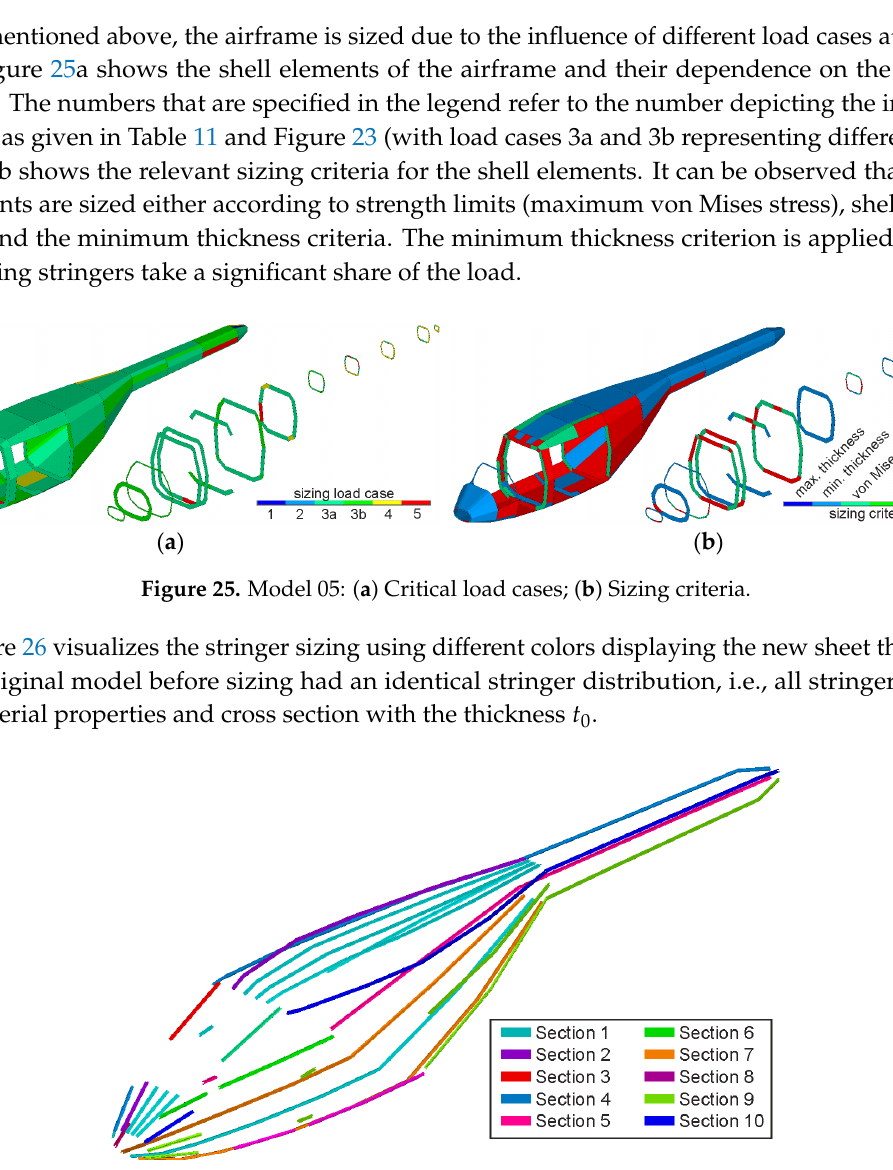
Figure 26. Model 05: Stringer sizing.